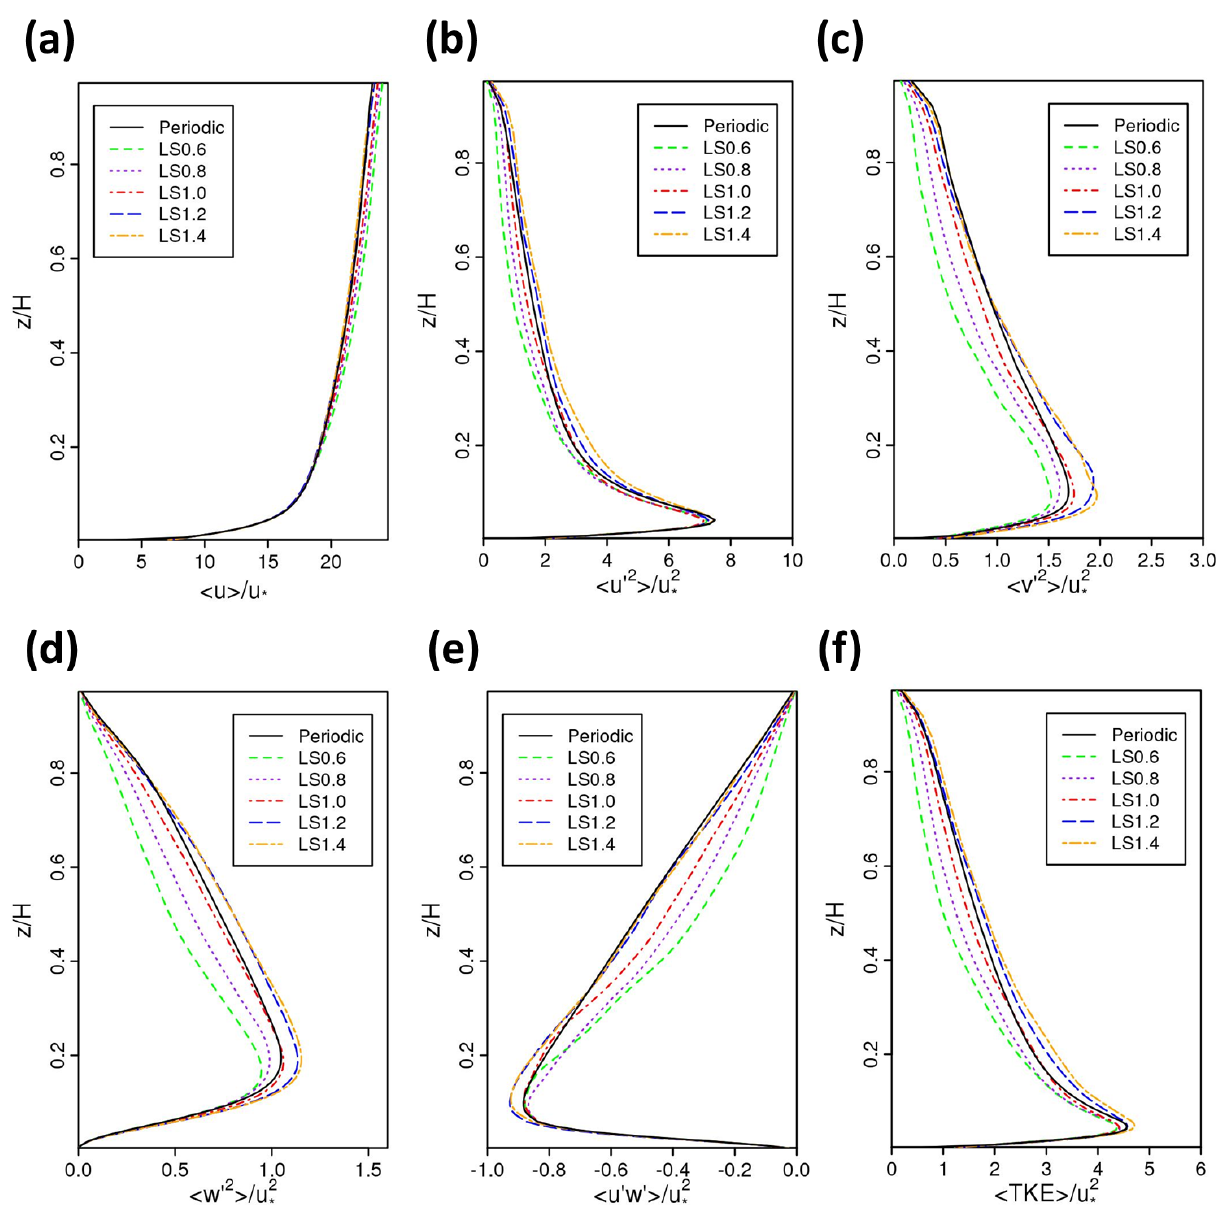
Figure 9. Vertical profiles (spatially and temporally averaged) of (a) (cid:104) u (cid:105) /u ∗ , (b) (cid:104) u (cid:48) 2 (cid:105) /u 2 ∗ , (c) (cid:104) v (cid:48) 2 (cid:105) /u 2 ∗ , (d) (cid:104) w (cid:48) 2 (cid:105) /u 2 ∗ , (e) (cid:104) u (cid:48) w (cid:48) (cid:105) /u 2 ∗ , and (f) (cid:104) TKE (cid:105) /u 2 ∗ at x/H = 10 with various integral length